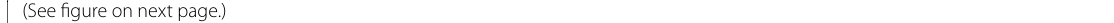
figure on next Fig. 1 Bioinformatics analysis of licorice in diabetic nephropathy. A Common targets between putative predicted targets of licorice and targets associated with DN in the GeneCards and DisGeNET databases. B Bioactive component-target network of licorice against DN. The green nodes denote the bioactive components in licorice, and the red nodes denote the corresponding targets of the components. C GO and ( D ) KEGG enrichment analysis of 40 targets from the network. E Among the 40 targets, the genes in red rectangles were targets of Glab, which were mainly enriched in the VEGF signaling pathway in